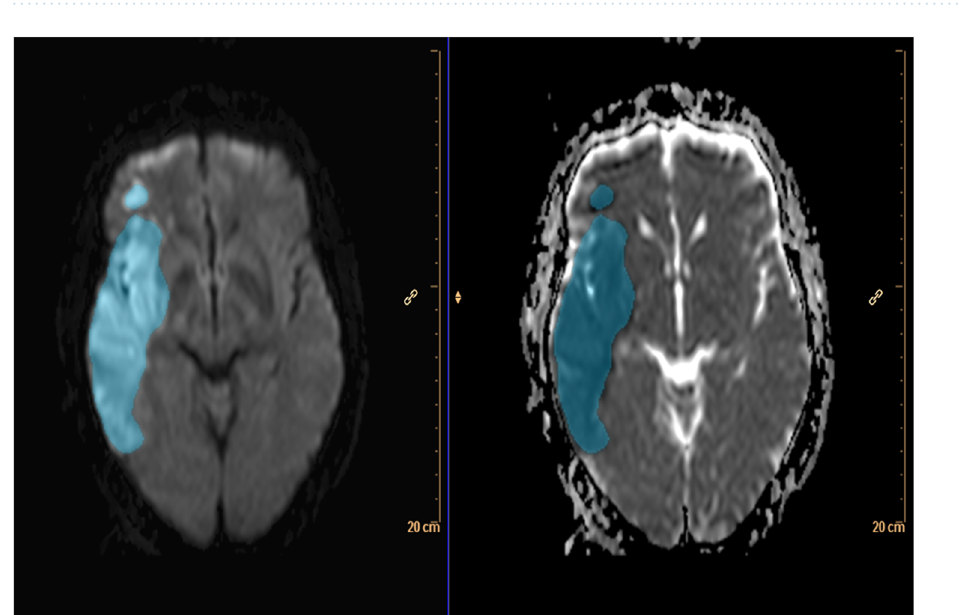
Figure 2. Segmentation of the final infarct volume (FIV) of the same patient as in Fig. 1 based on manual segmentation one day after initial imaging on DW-MRI (left: axial DWI, right: corresponding apparent diffusion coefficient (ADC)-map) after successful MT (mTICI 3, group